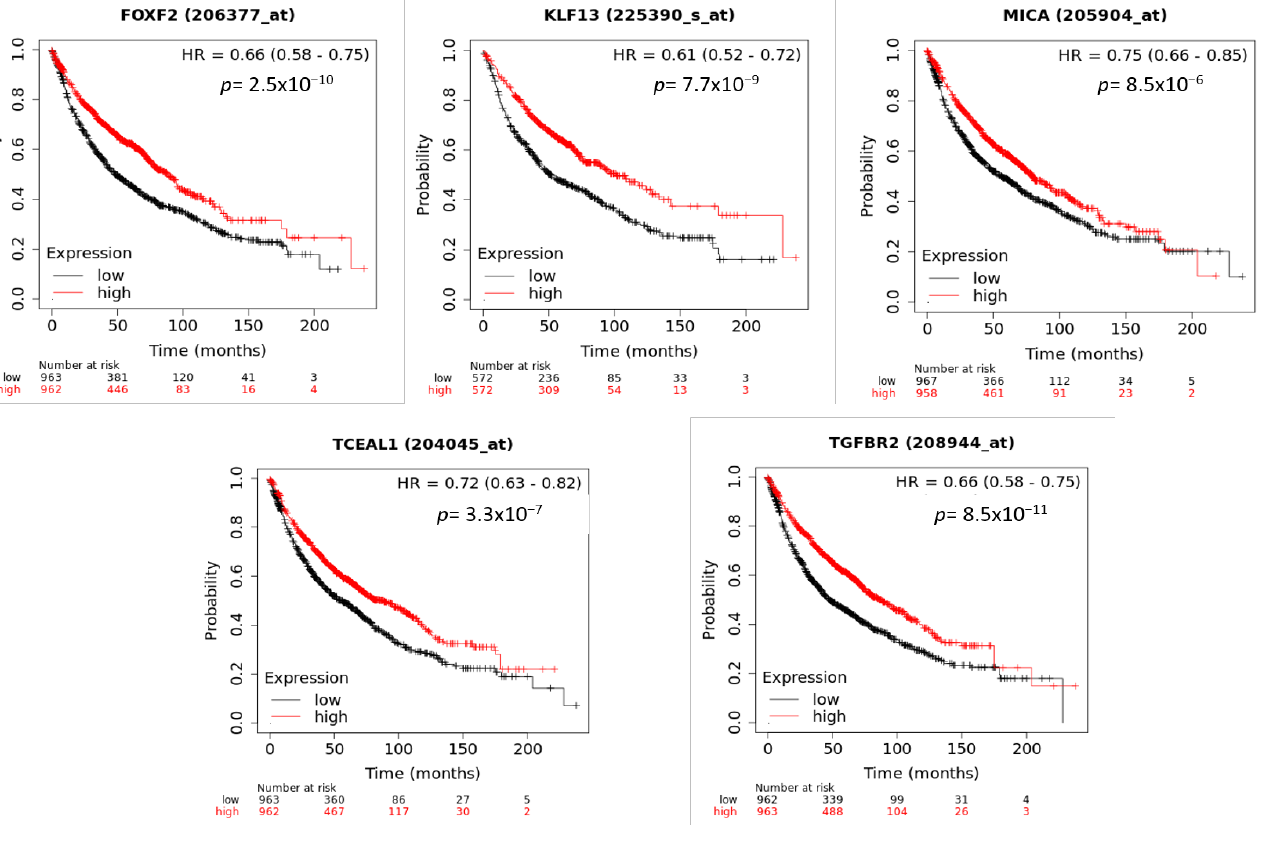
Figure 8. Clinical outcomes significantly associated with target gene expression in lung cancer. The Kaplan – Meier survival plots were obtained using the Kaplan – Meier plotter website. HR: hazard Kaplan–Meier survival plots were obtained using the Kaplan–Meier plotter website. HR: hazard ratio.